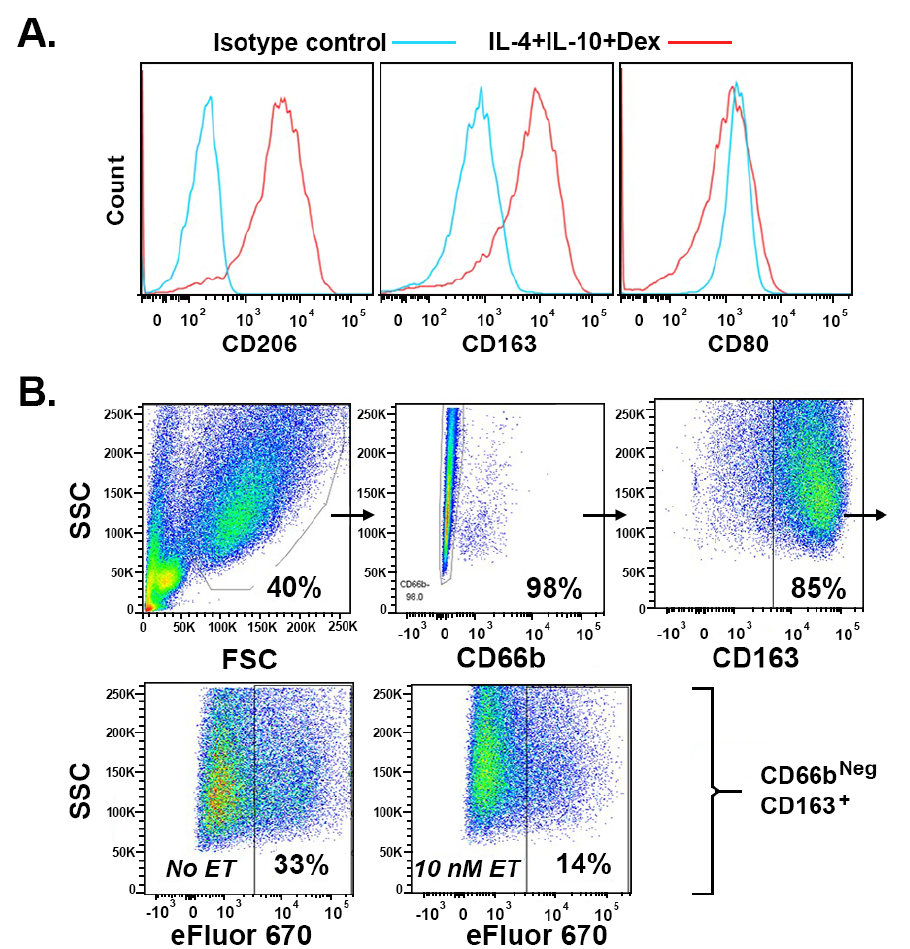
Figure 1. M2(IL-4+IL-10+Dex) macrophages express M2 markers and are more efferocytic in the absence of ET. ( A ) M2(IL-4+IL-10+Dex) macrophages express CD206 and CD163 but not CD80; ( B ) The representative gating of efferocytic M2(IL-4+IL-10+Dex) macrophages that were pretreated in the absence (No ET) or presence (10 nM ET) of ET: After excluding un-engulfed apoptotic polymorphonuclear neutrophil (PMN) (FSC vs. SSC, upper left) and macrophages that have surface bound apoptotic PMN detected with the PMN-specific marker CD66b (upper center), the M2 macrophages were selected by positivity for CD163 (upper right). The efferocytic cells were identified as CD163 + CD66b − macrophages that had internalized eFluor670-labeled apoptotic PMN. The data are representative of five independent experiments showing similar results.